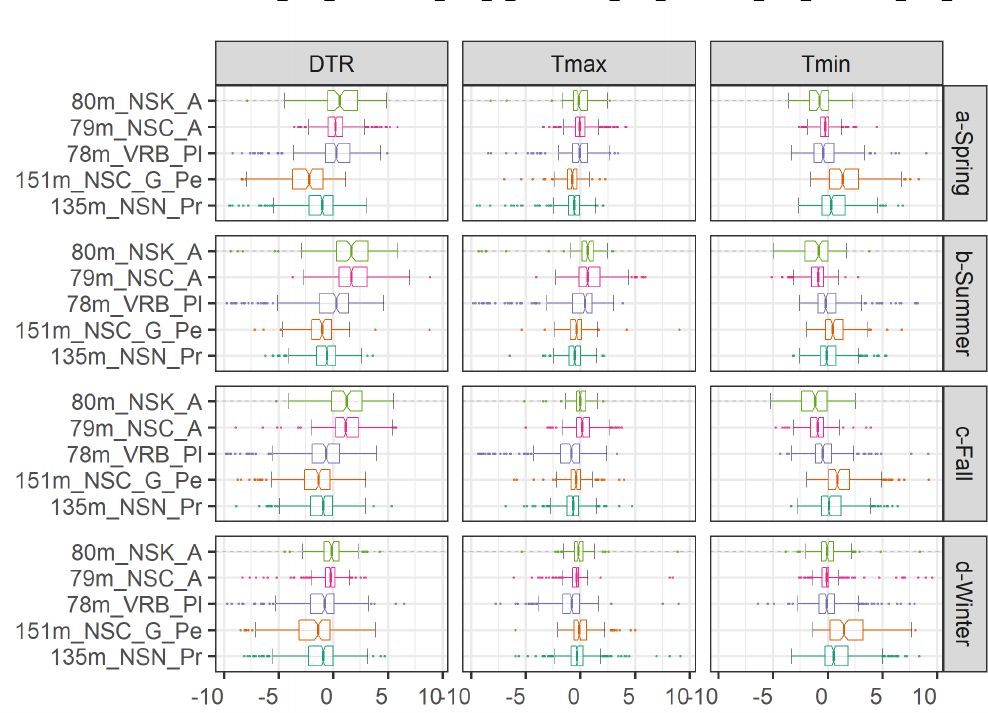
Figure 8. R1: Annual and seasonal variation of T max , T min , and DTR differences in respect to Novi Sad reference climatological station for the 2013–2018 period.